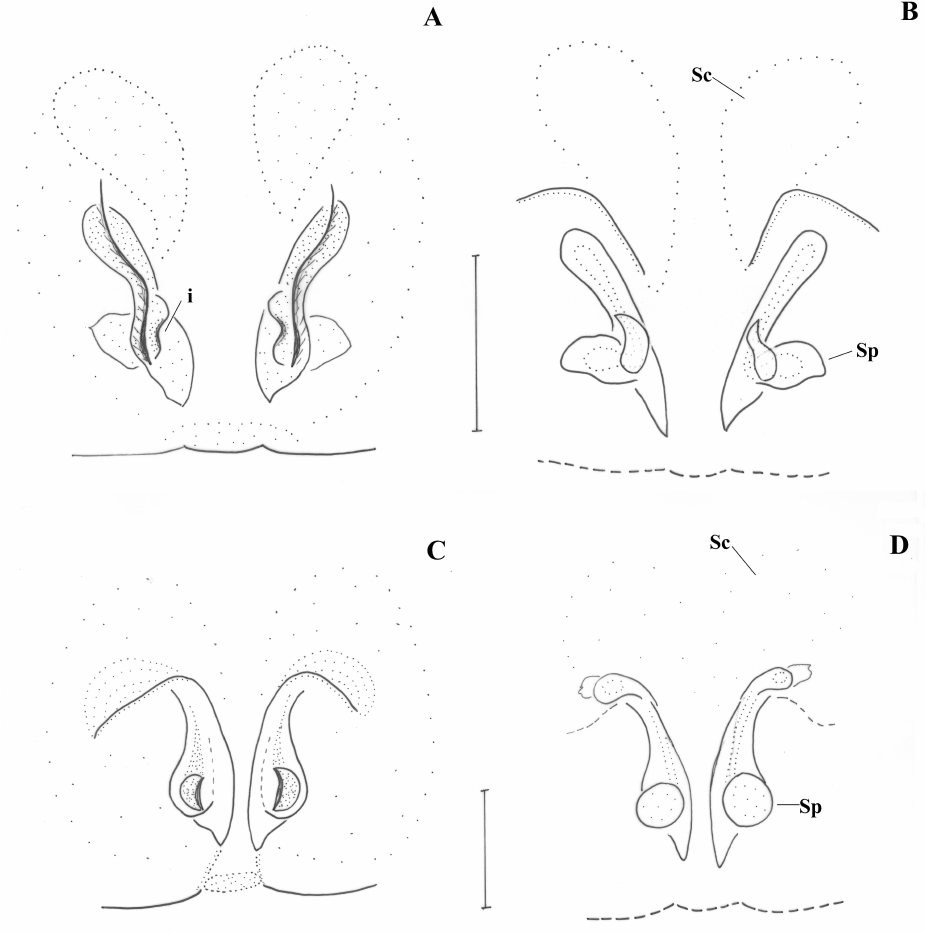
Figure 15. Zelotes histio n.sp. ( A , B ) Fully mature (holotype), ( C , D ) Penultimate form (FC: 17147). ( A , C ) Epigyne. ( B , D ) Vulva. i: introductory orifice, Sc: spermathecal sac, Sp: